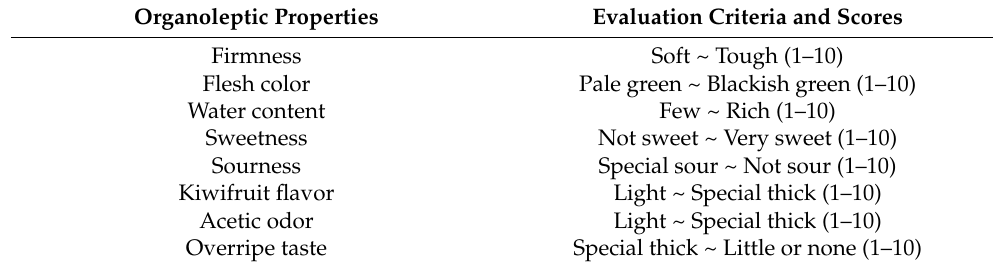
Table 1. Sensory test scoring